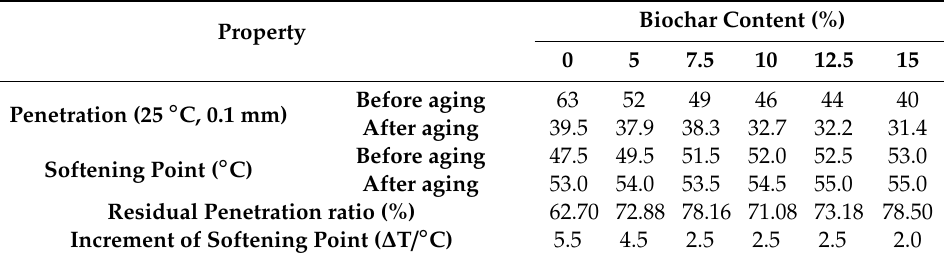
Table 4. Properties of conventional asphalt binder after short-term